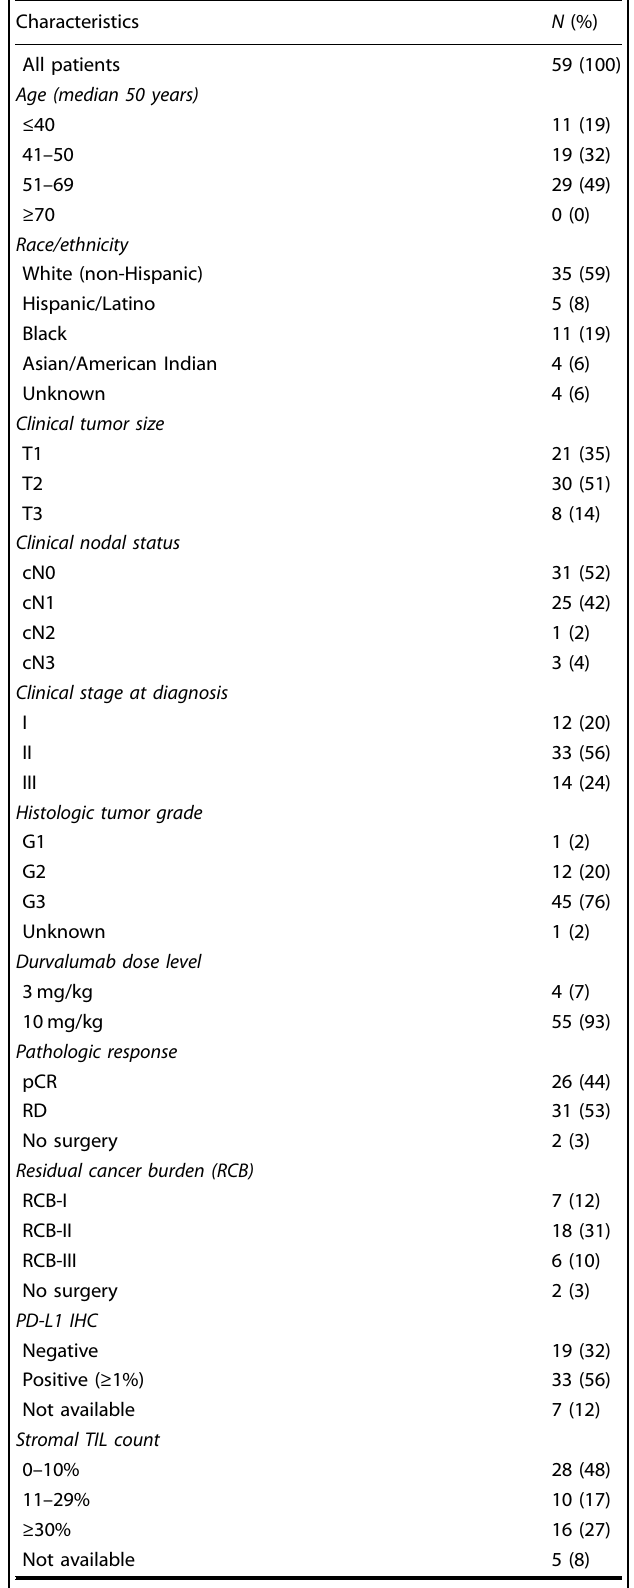
Table 1. Patients